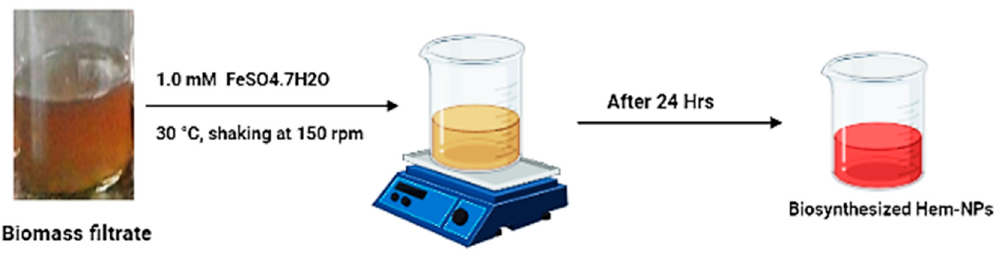
Figure 1. Biosynthesis of Hem-NPs using the biomass filtrate of A. niger AH1.